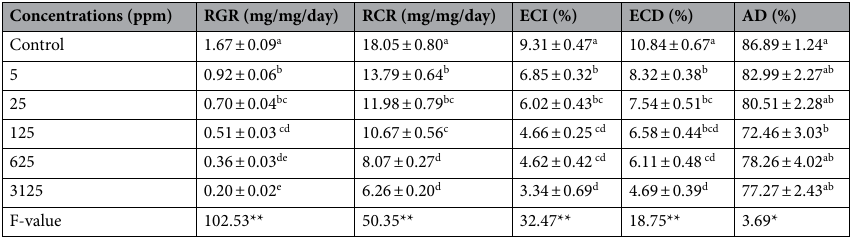
Table 3. Nutritional indices of S. litura when 6 days old instar larvae were fed on different concentrations of gallic acid. **Significant at 1%, *Significant at 5%. Values are Mean ± SE. Means followed by the same letter within the columns are not significantly different according to Tukey’s test at p ≤ 0.05.